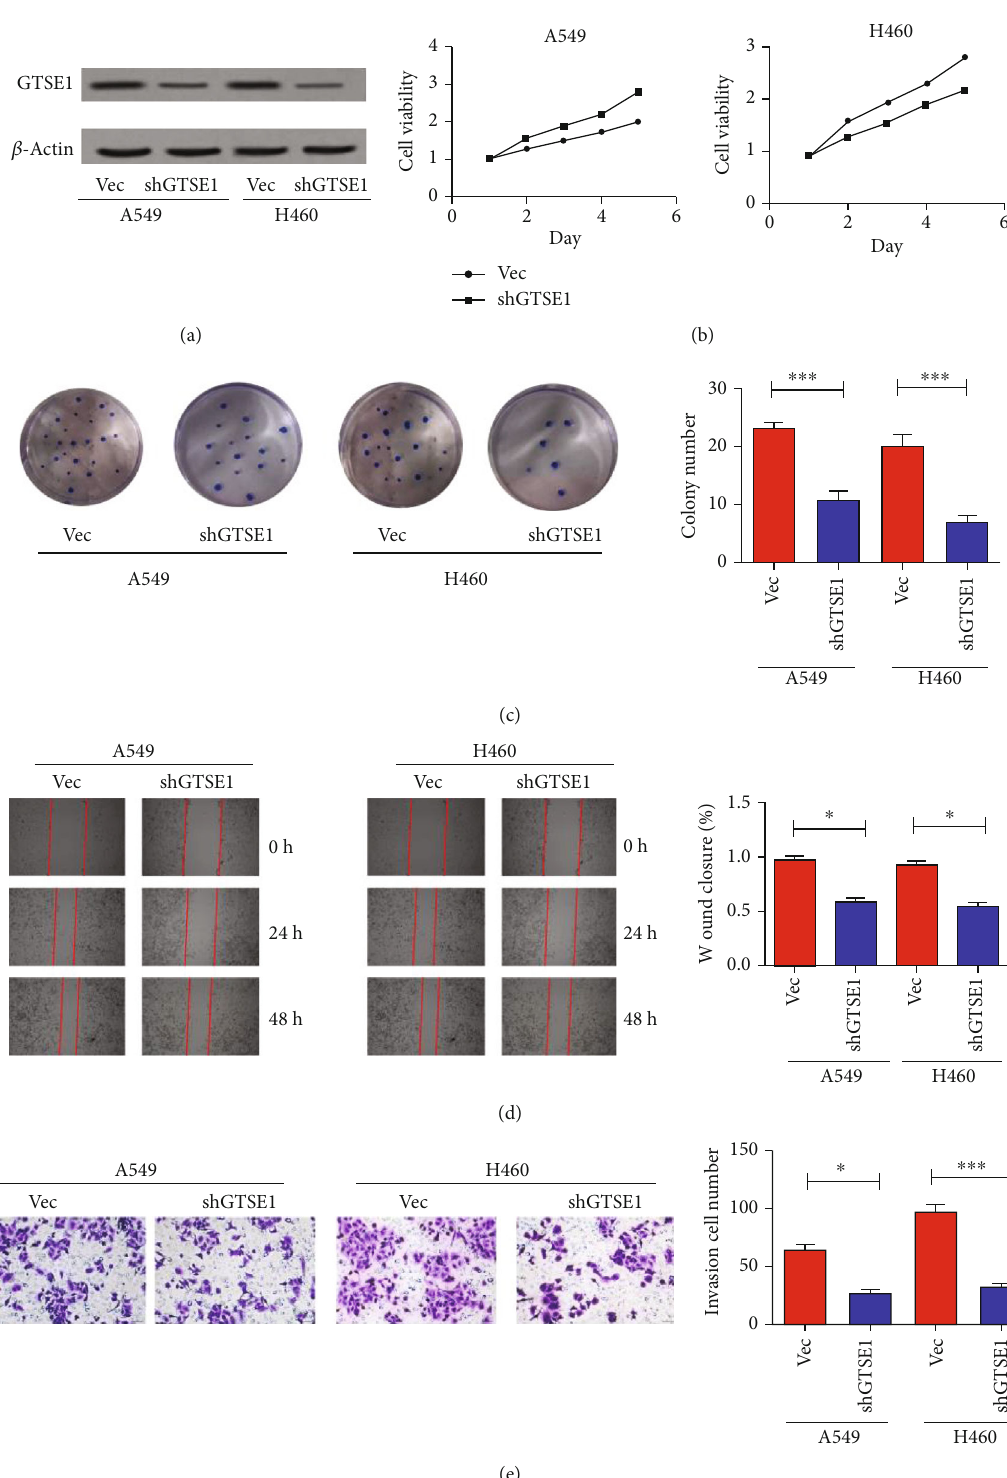
Figure 4: Knockdown of GTSE1 inhibited proliferation, migration, and invasion of cells A549 and H460 in lung cancer. (a – e) GTSE1 was silenced in A549 and H460 cells. (a) The silence of GTSE1 in cells A549 and H460 was validated by using the WB assay. The CCK8 assay (b), colony formation (c), wound healing assay (d), and transwell invasion assay (e) were performed to evaluate cell proliferation, migration, and invasion. ∗ p < 0 : 05 and ∗∗ p < 0 : 01